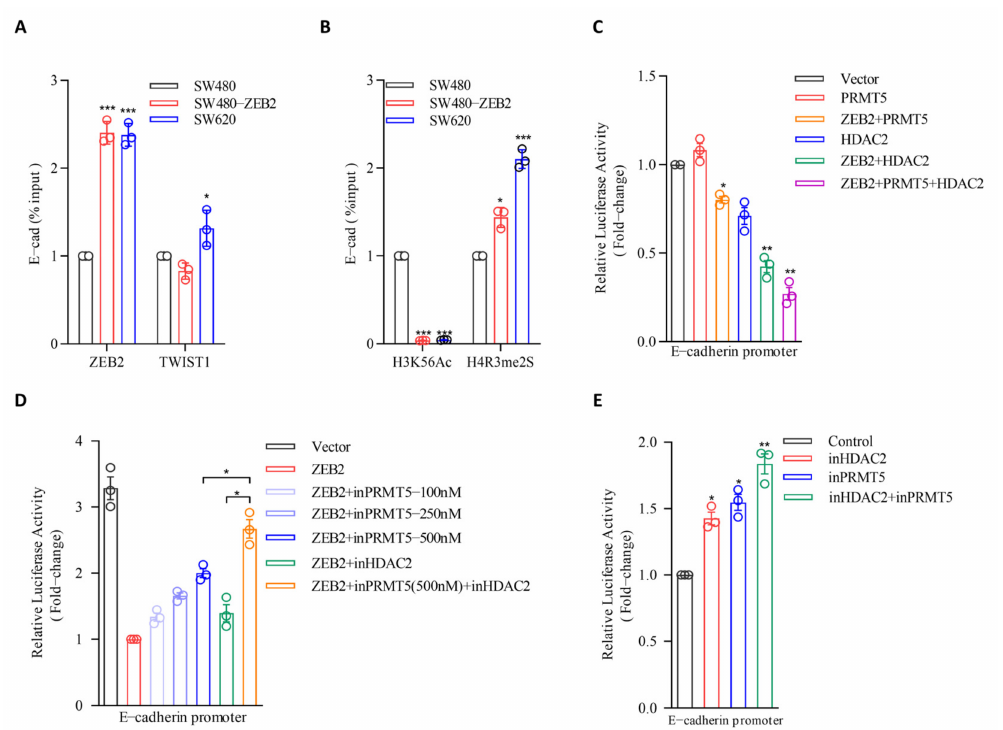
Figure 5. PRMT5 and HDAC2 are responsible for ZEB2-mediated E-cadherin repression in CRC. ( A ) ChIP assay of TWIST1 and ZEB2 levels at the E-cadherin promoter in the SW480-ZEB2 cell lines, their respective control cell lines, and SW620. ‘Percentage of input’ indicates the ratio of the DNA fragment of each promoter region bound by TWIST1 and ZEB2, to the total amount of input DNA without TWIST1 and ZEB2, specific antibody pull-down. ( B ) ChIP assay of H4R3 demethylation (H4R3me2S) and H3K56 acetylation (H3K56ac) levels at the E-cadherin promoter in SW480-ZEB2 cell lines, their respective control cell lines, and SW620. ( C ) SW480 cells express pGL3-E-cadherin promoter-Luc with plasmid ZEB2, PRMT5 or HDAC2, and luciferase activity was assayed, 48 h later, luciferase activity was assayed and normalized to Renilla. ( D ) SW480+Vector and SW480+ZEB2 cells express plasmid pGL3-E-cadherin promoter-Luc. InPRMT5 (GSK3326595) and inHDAC2 (Santacruzamate A) were added to the cell medium, and luciferase activity was assayed, 48 h later, luciferase activity was assayed and normalized to Renilla. ( E ) SW620 cells express plasmid pGL3-E-cadherin promoter-Luc. InPRMT5 (GSK3326595) and inHDAC2 (Santacruzamate A) were added to the medium, and luciferase activity was assayed, 48 h later, luciferase activity was assayed and normalized to Renilla. All the data are representative of three independent experiments. Data points represent the mean ± SD. * p ≤ 0.05; ** p ≤ 0.01; *** p ≤